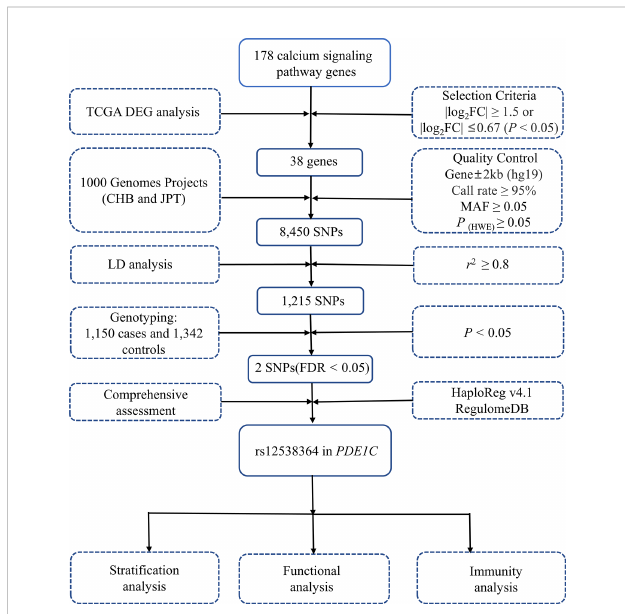
FIGURE 1 Flow diagram of SNP selection. The work fl ow of the analysis includes the screening criteria and the methods. MAF, minor allele frequency; HWE, Hardy-Weinberg equilibrium; LD, linkage